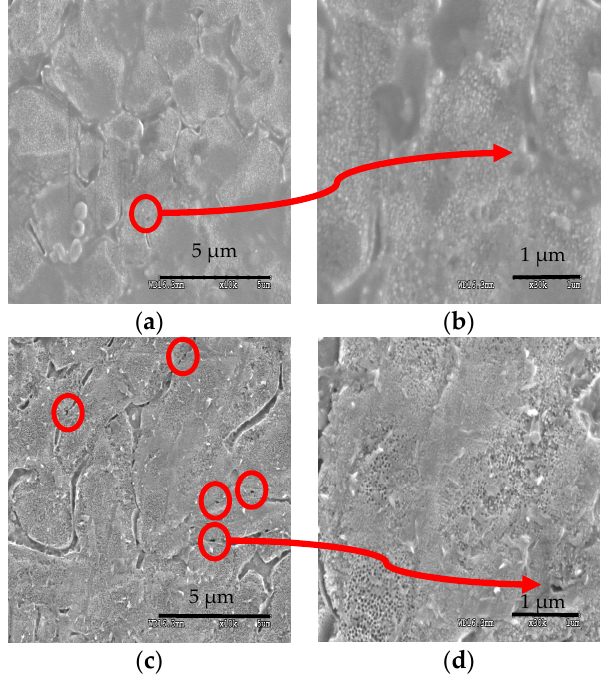
Figure 17. Low- and high-magnification FESEM images of the annealed samples at 200 °C in ( a,b ) air atmosphere and ( c,d ) Ar gas after the corrosion test.